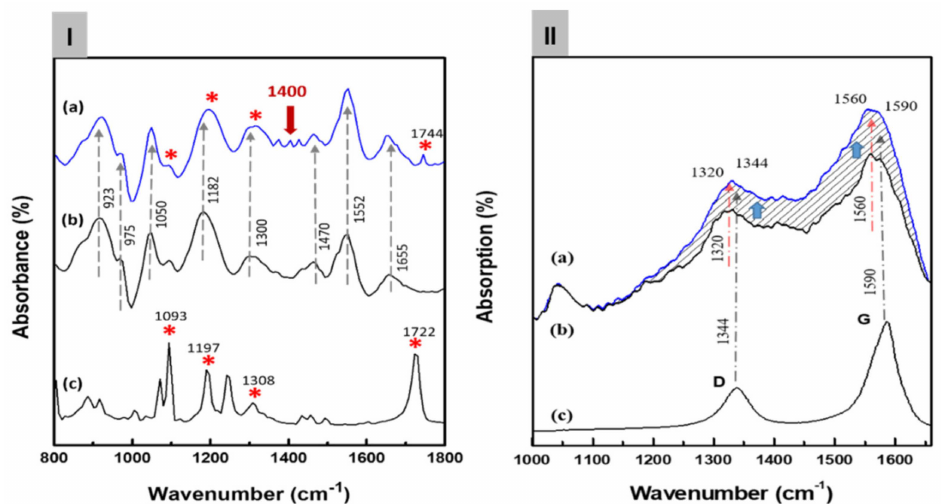
Figure 3. ( I ) The Fourier transform infrared (FT-IR) spectra of the C8F-doped-PPy/PLA@ SWCNT nanocomposite: ( a ) the C8F-doped-PPy/PLA@ SWCNT composite, ( b ) the C8F-doped PPy@SWCNT nanorods, and ( c ) the PLA. In the figure, the meaning of ‘*’ indicates the IR absorp-tion peak of PLA molecules. The presence or absence of PLA present in the surface layer of C8F-doped-PPy/PLA@ SWCNT nanocomposite is expressed. ( II ) The FT-Raman spectra of the C8F-doped-PPy/PLA@ SWCNT nanocomposite: ( a ) the C8F-doped-PPy/PLA@ SWCNT composite, ( b ) the C8F-doped-PPy nanorods, and ( c ) the SWCNT. (The dotted line indicates that the Raman intensity changed as the stretching mode of C8F-doped-PPy and the tangential mode of SWCNT